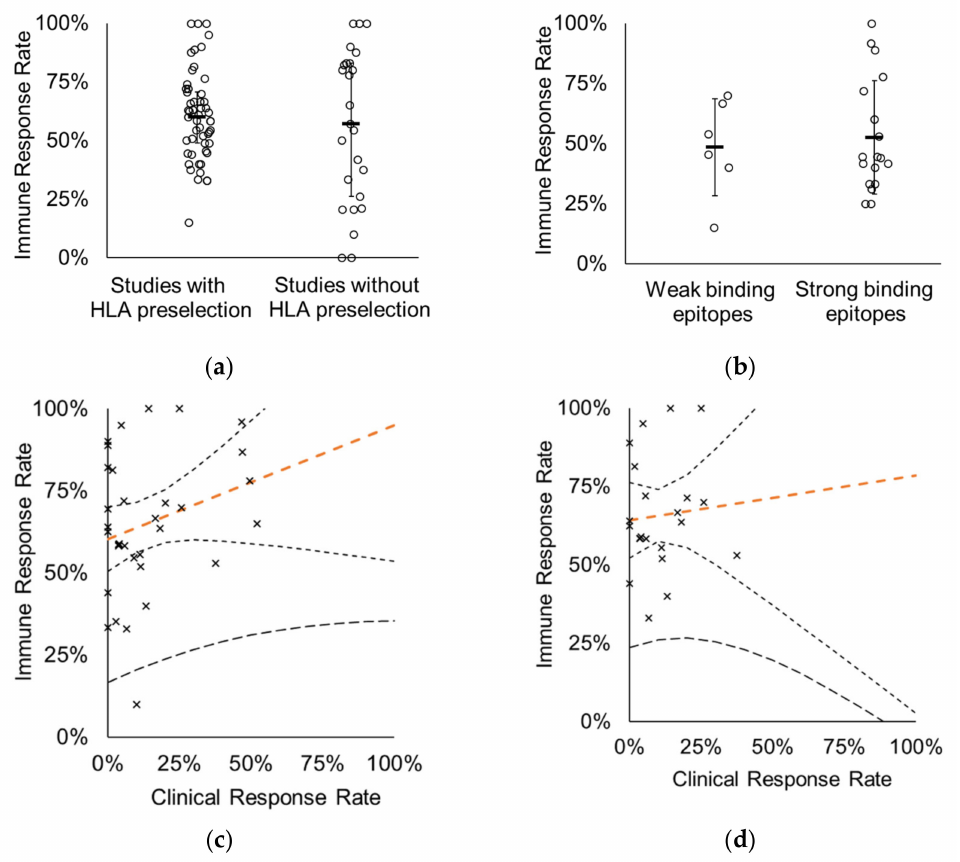
Figure 1. Immunogenicity of cancer vaccines is not predictive for efficacy. ( a ) IRR of CTs with ( n = 52) or without ( n = 25) HLA preselection of subjects. Medians (marked with horizontal line) were 60% and 57%, respectively ( p = 0.4490). Each mark represents one CT. Error bars represent the standard deviation of the datasets. ( b ) IRR of CTs does not correlate with predicted binding affinity of vaccine epitopes. Strong ( n = 18) and weak ( n = 6) binding epitopes were grouped based on the predicted binding affinity to the HLA allele used for subject preselection. Strong binders are epitopes with < 2 IEDB percentile rank ( p = 0.6657). Each mark represents one peptide. ( c ) IRR of vaccines does not correlate with clinical responses ( r = 0.2594, p = 0.1495). Forty-two CTs of 33 vaccines were used in the analysis. ( d ) IRR of vaccines does not correlate with CRR in CTs where subjects are preselected based on HLA ( r = 0.0782, p = 0.7293). Twenty-nine CTs of 28 vaccines were used in the analysis. Orange dashed line: perpendicular trend line with 95% confidence interval bands (95% prediction interval band is shown by thicker dashed line). Each mark represents one